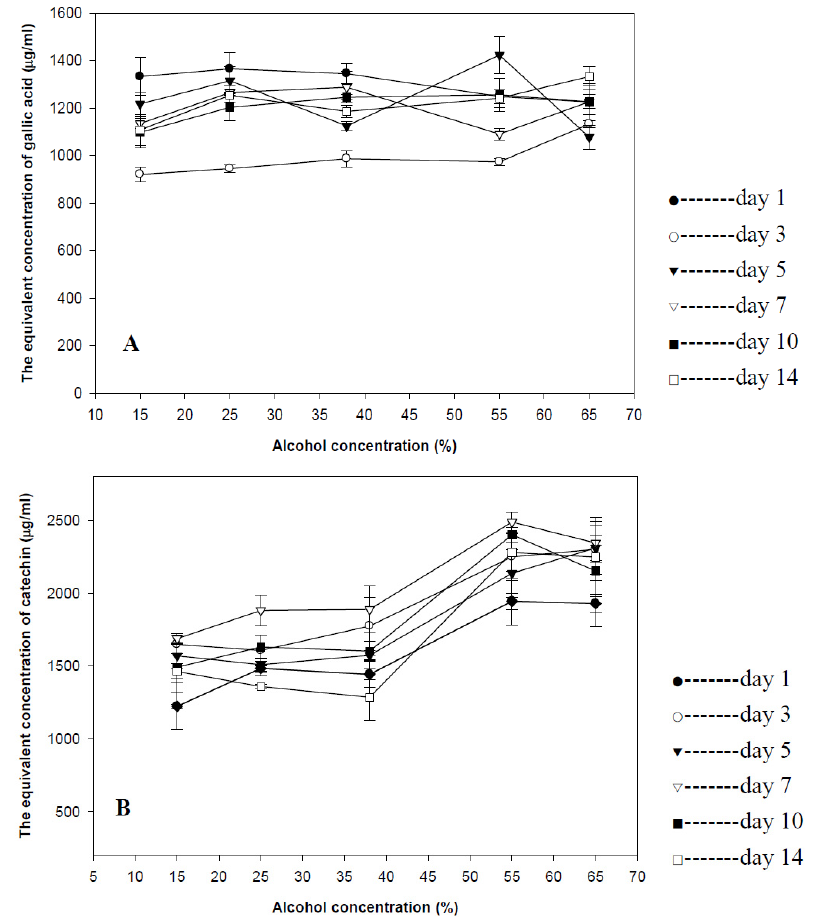
Figure 3. Phenolic content of goji wine. ( A ) Total phenolic content of goji wine; ( B ) total flavonoid content of goji wine. Results were expressed as mean ± standard deviation ( n =